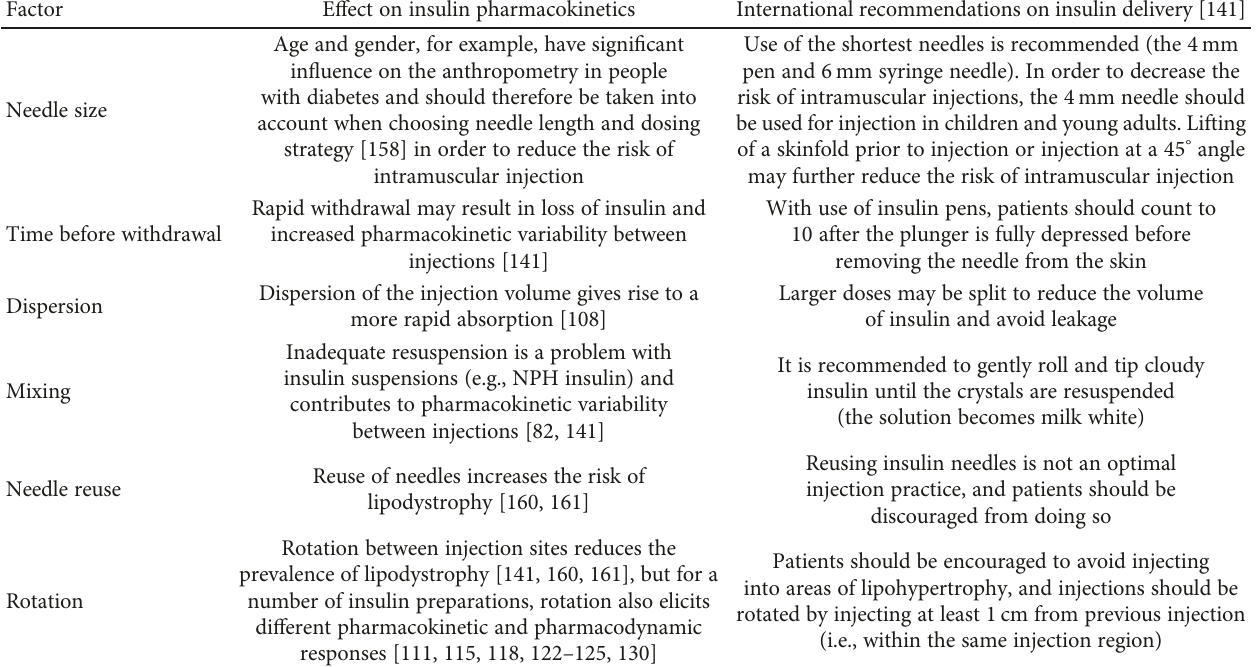
Table 4: Factors related to the injection technique that in fl uence insulin pharmacokinetics and international recommendations on insulin delivery that aim at reducing pharmacokinetic variability between